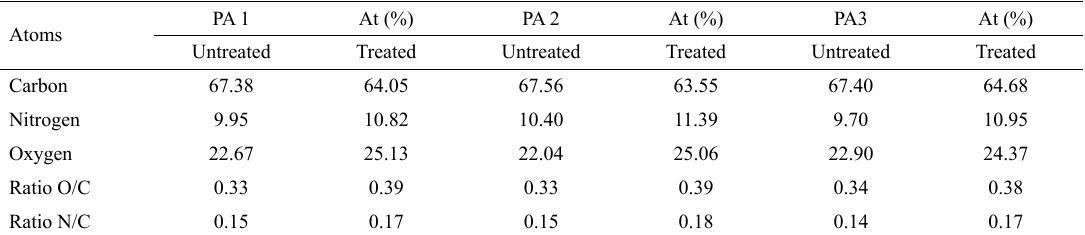
Table 4. Atomic Percentage (At %) obtained by EDS analysis to untreated and plasma treated fabrics with dosage of 2.5 kW.min.m -2 . PA 1 Atoms Carbon